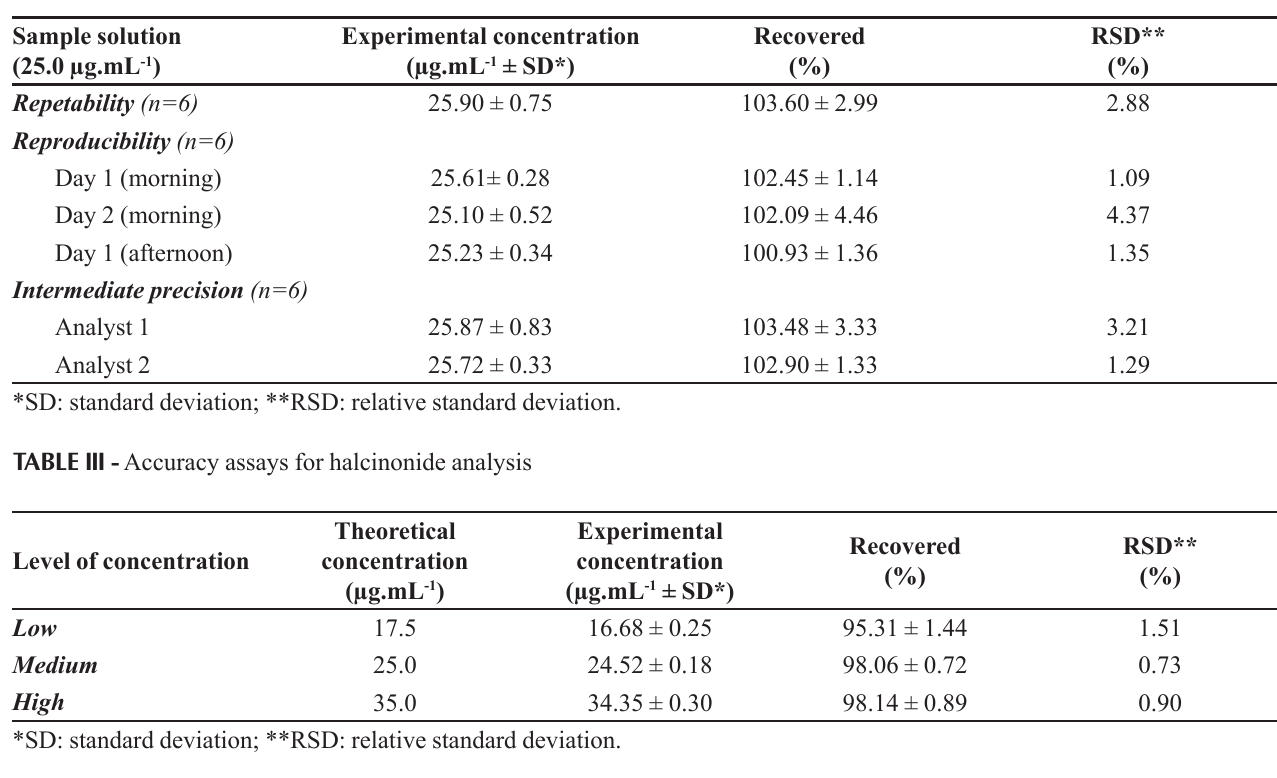
TABLE II - Repeatability, reproducibility and intermediate precision data of halcinonide analysis Sample solution